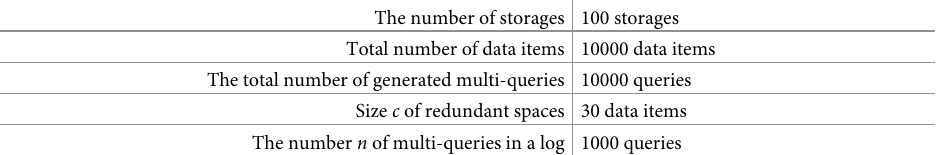
Table 1. Default parameters in simulations.